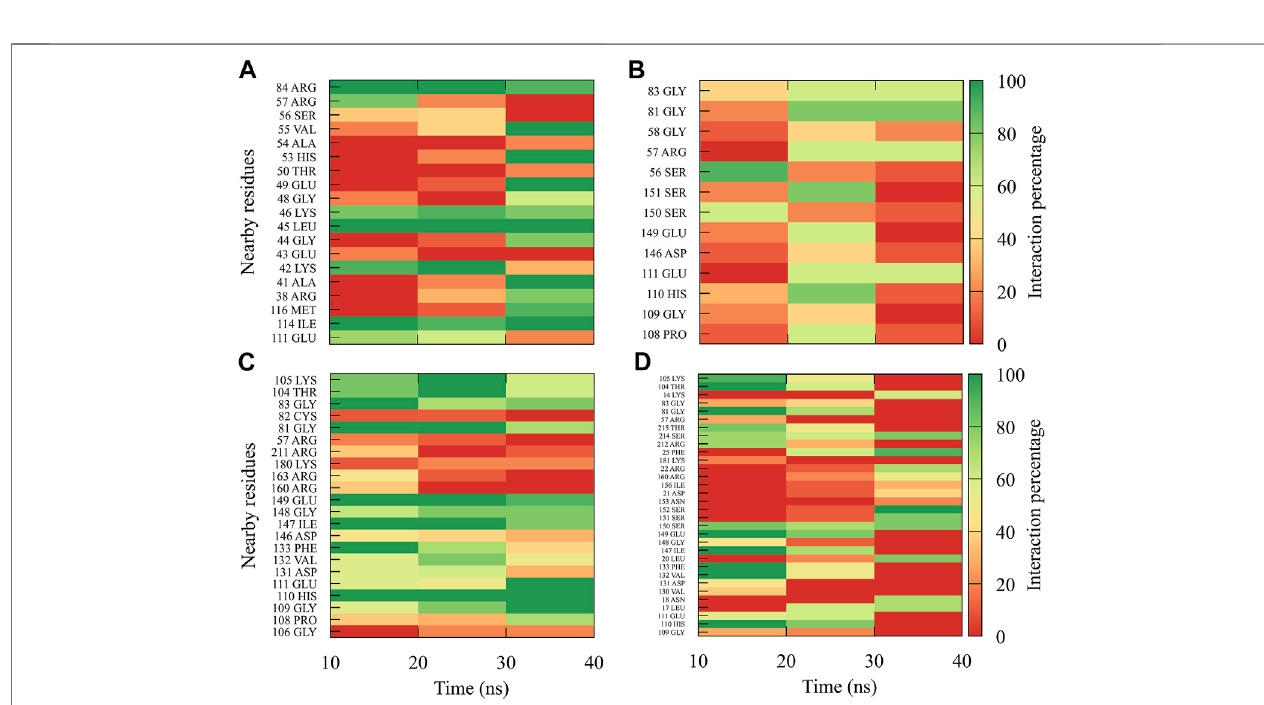
FIGURE 6 | Contact frequency maps for the compound 8md , bound to the region of the KDKE tetrad of the (A) DENV1, (B) DENV2, (C) DENV3, and (D) DENV4. Red represents that the contact frequency was 0%, while green represents that the contact frequency was 100%.